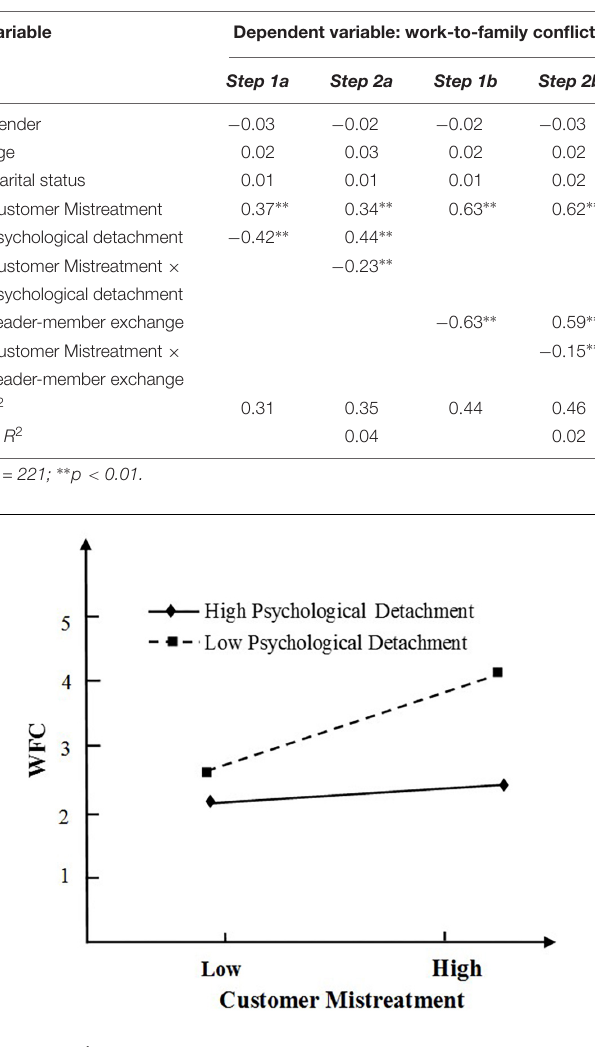
conditional indirect effects of customer mistreatment on family satisfaction via WFC at high and low values of psychological detachment and LMX respectively. Results (see Table 5 ) indicate that the indirect effects of customer mistreatment on family satisfaction via WFC decreased as psychological detachment